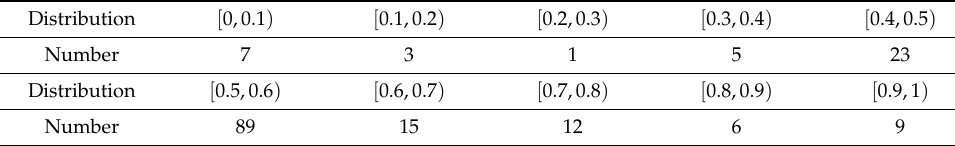
Table 2. Number distribution of the initial opinion